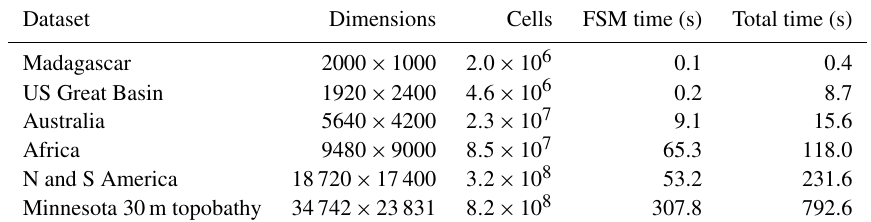
Table 1. Datasets used, their dimensions, and algorithm wall times. Tests were performed on the Comet cluster run by XSEDE (see the main text for full specifications). Times for Fill–Spill–Merge (FSM time) alone and this time plus the depression hierarchy construction time (total time) are shown. Topographic data for Madagascar, the US Great Basin, Australia, Africa, and North and South America were clipped from the GEBCO_08 30arcsec global combined topographic and bathymetric elevation dataset (GEBCO, 2010). The Minnesota 30m topobathy data are the merged result of two data sources. The topography is resampled from the Minnesota Geospatial Information Office’s 1m lidar elevation dataset (MNGEO – Minnesota Geospatial Information Office, 2019). Bathymetric data were provided by the Minnesota Department of Natural Resources (MNDNR – Minnesota Department of Natural Resources, 2014). Richard Lively of the Minnesota Geological Survey merged and combined these datasets.